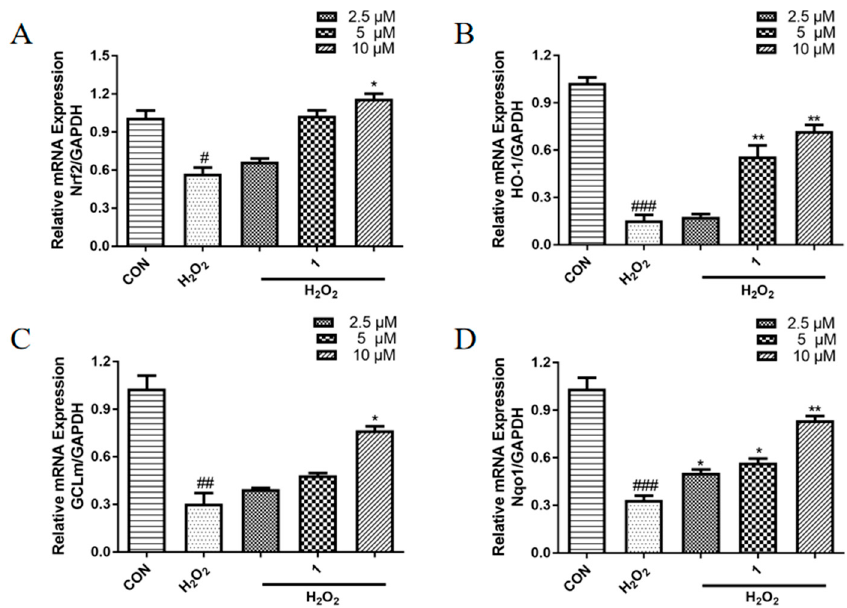
Figure 6. Effects of 1 on the mRNA expression levels of ( A ) Nrf2; ( B ) HO-1; ( C ) GCLm; ( D ) Nqo1. PC12 cells were incubated with compound 1 at 2.5, 5, or 10 µ M, combined with H 2 O 2 (750 µ M), for 24 h before assessment using qRT-PCR. GAPDH was used as the internal control. Values are representative of three independent experiments. # p < 0.05, ## p < 0.01, ### p < 0.005 vs. control cells. * p < 0.05, ** p < 0.01 vs. H 2 O 2 -induced